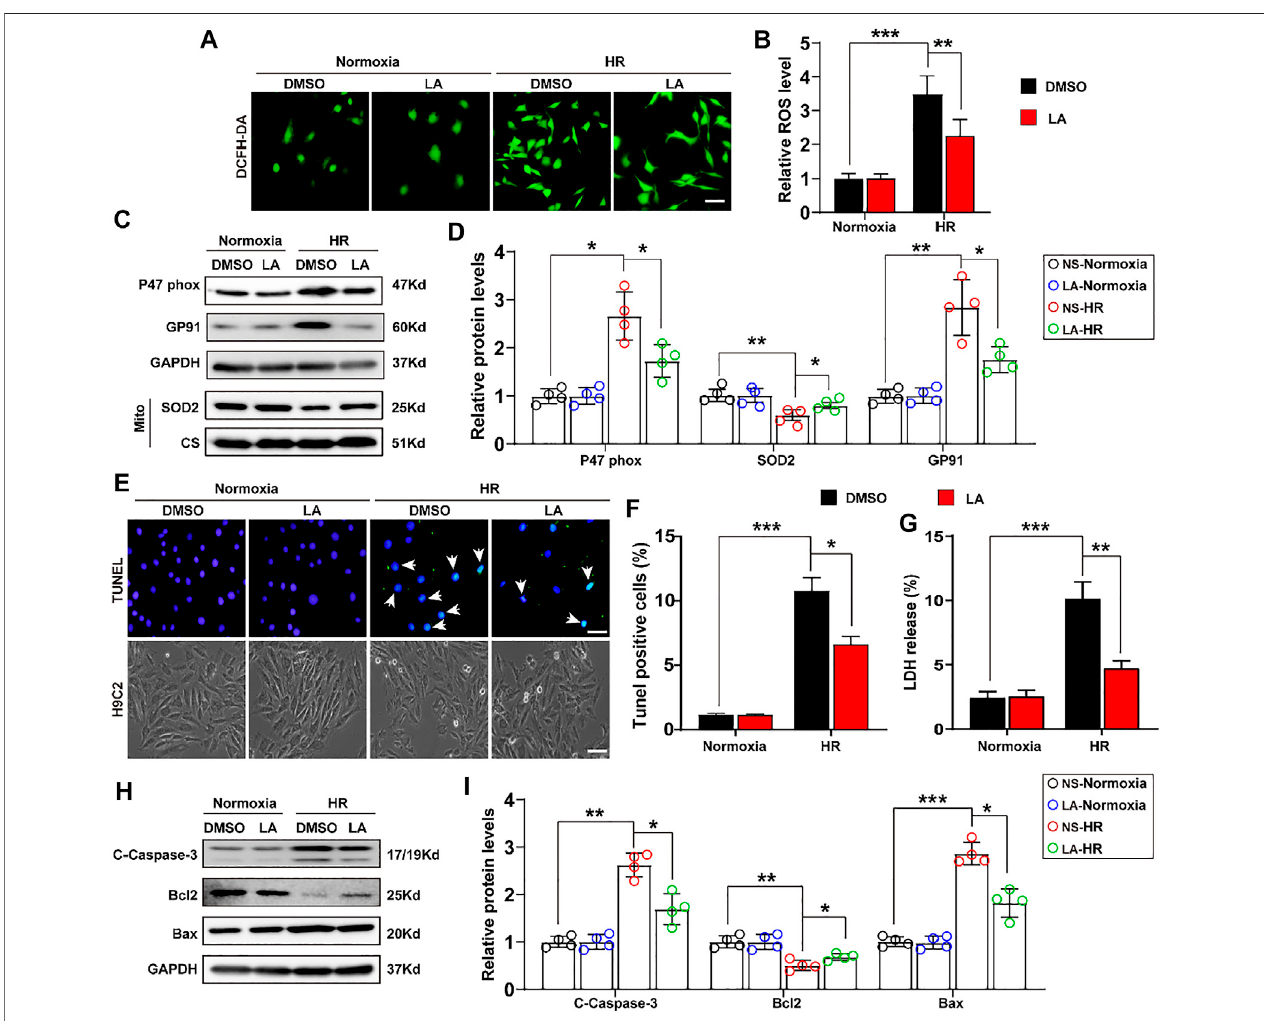
FIGURE4| LAcountersoxidativestressandapoptosisinhypoxiareoxygenation(HR)inH9C2cells.LAandDMSOpretreatedH9C2cellsweresubjectedtoHRor Normoxia (A,B) .RepresentativeROSlevelsofH9C2cellsweremeasured byincubatingwithDCFH-DAprobe,andthenanalysis fl uorescenceintensity,Scarbar:50 μ m (C,D) . Representative western blot and analysis of p47 phox, SOD2 and GP91 in H9C2 cells, normalized to GAPDH (n (cid:1) 4) (E,F) . Representative Tunel and cell morphology, and positive cells analysis in H9C2 cells, Scar bar: 50 μ m (G). LDH release was detected by LDH assay kits (H – I). Representative western blot and analysis of cleaved-caspase-3 (C-caspase-3), Bax and Bcl2 in H9C2 cells, normalized to GAPDH ( n (cid:1) 4). Data are presented as the mean ± SEM, with each point representing a mouse. * indicates p < 0.05, ** indicates p < 0.01, *** indicates p < 0.001.